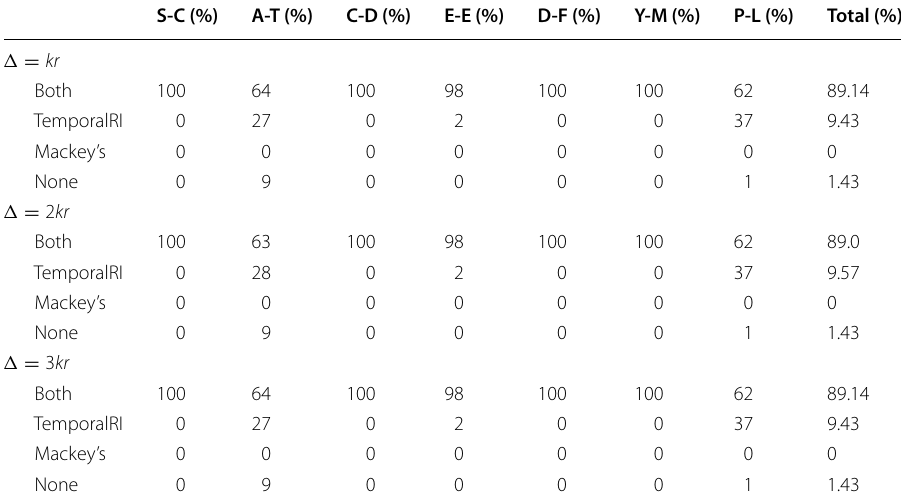
Table 2 Number of experiments with k = 3 completed by both algorithms, TemporalRI only, Mackey’s algorithm only and none of